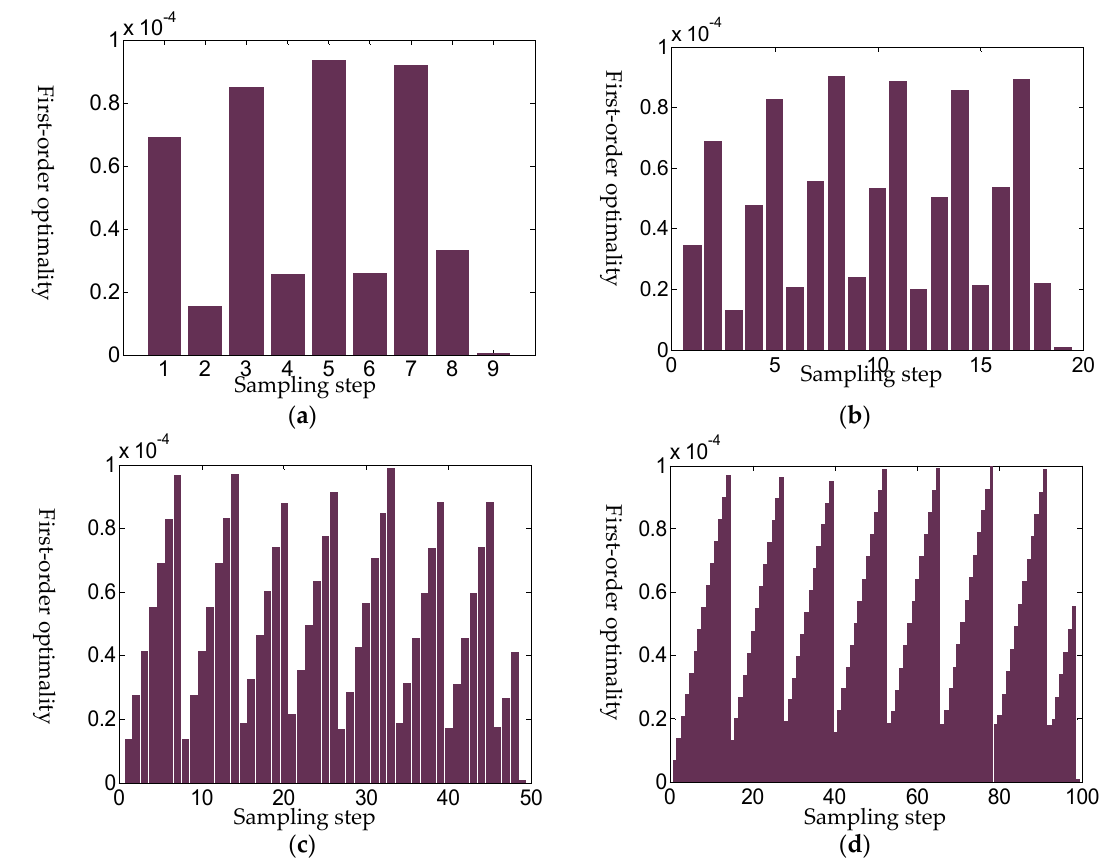
Figure 9. First-order optimality with different sampling steps under loose intermediate iteration termination condition10 − 4 . ( a ) Sampling steps of 10; ( b ) Sampling steps of 20; ( c ) Sampling steps of 50; ( d ) Sampling steps of 100.